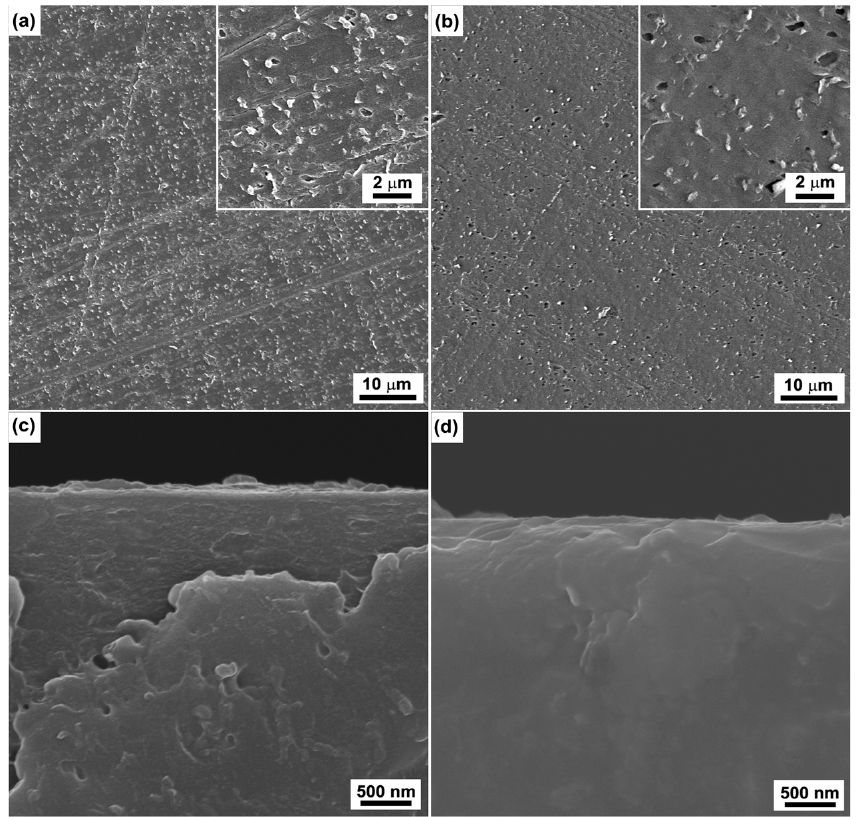
Figure 3. Typical surface SEM images of the ABS substrates treated by Cr ions with bias voltages of − 600 V ( a ) and − 1000 V ( b ) for 30 s. ( c ) and ( d ) are the corresponding cross-sectional images of ( a ) and ( b ), respectively.